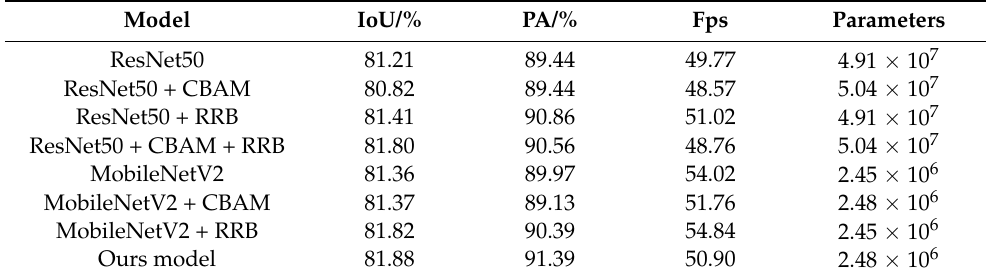
Table 5. Comparison results of each module on model